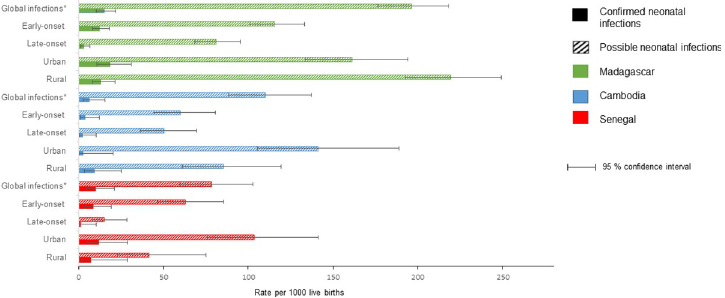
Fig 3. Incidence of severe neonatal infections (per 1,000 live births). Early-onset infections are defined as cases occurring between 0 and 6 days and late-onset infections as cases occurring between 7 and 28 days. � Global infections incidence is defined as early-onset and late-onset infections